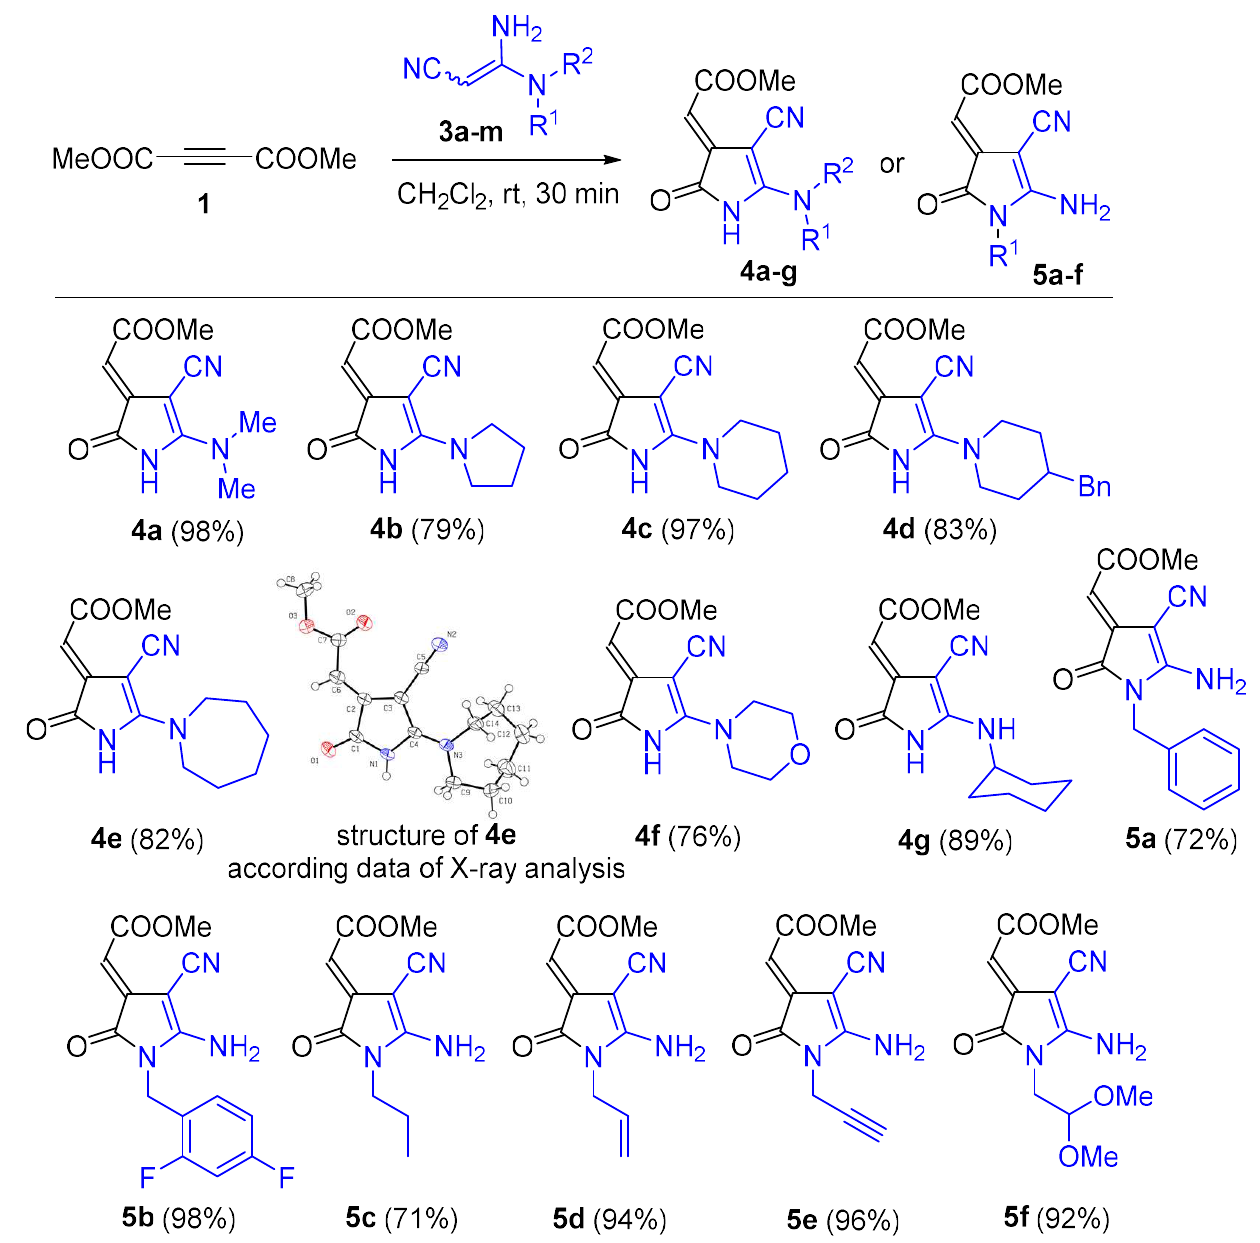
Scheme 2. Reaction of DMAD ( 1 ) with 3,3-Diaminoacrylonitriles 3a – m . Substrate Scope of 3,3-Dia-